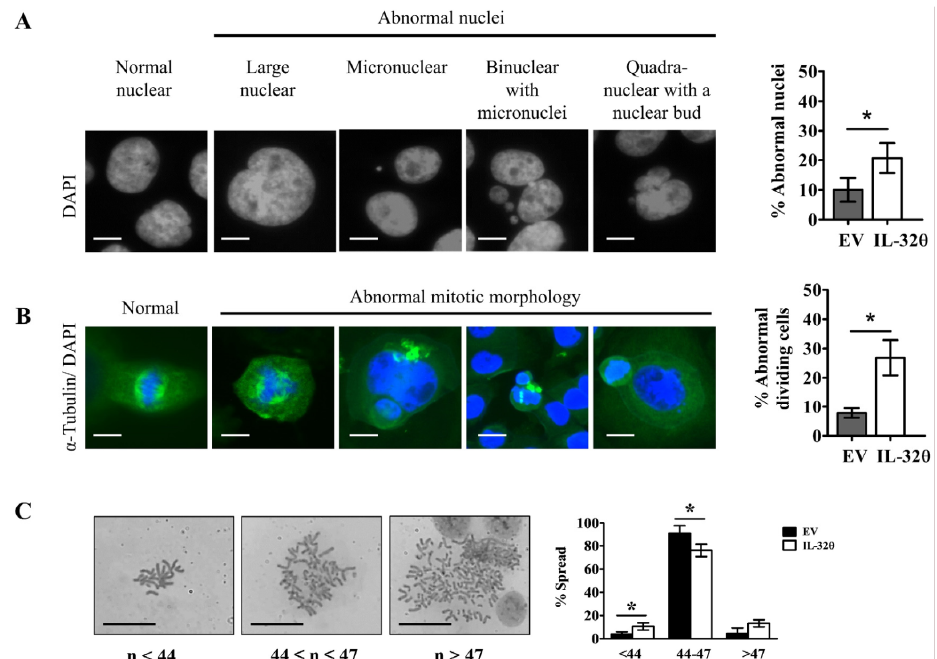
Figure 3. Abnormal nuclear morphology, abnormal mitosis, and genomic instability in cells with and without (control) IL-32 θ expression. ( A ) Morphology of nuclei stained with DAPI assessed by fluorescence imaging. Color image was converted to grayscale to count abnormal nuclei. Scale bar, 10 µ m. ( B ) Immunofluorescence assay to assess abnormal mitotic division. Cells and nuclei are stained with α -tubulin-FITC (green) and with DAPI (blue), respectively. Scale bar, 10 µ m. ( C ) Chromosome spread and ratios (%) of metaphase spread (<47, 44–47, >47) in each group. Scale bar, 20 µ m. * p < 0.05 (Student t -tests). Results are representative of three independent